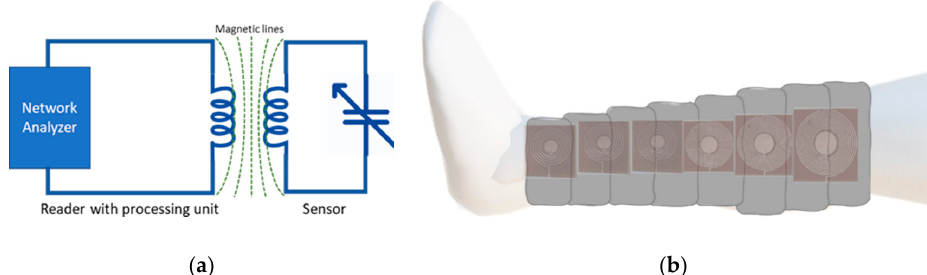
Figure 1. ( a ) Schematic diagram of wireless LC sensing system showing sensor and reader coil connected with a vector network analyzer ( b ) An application demonstration using flexible pressure sensors under the compression bandage.